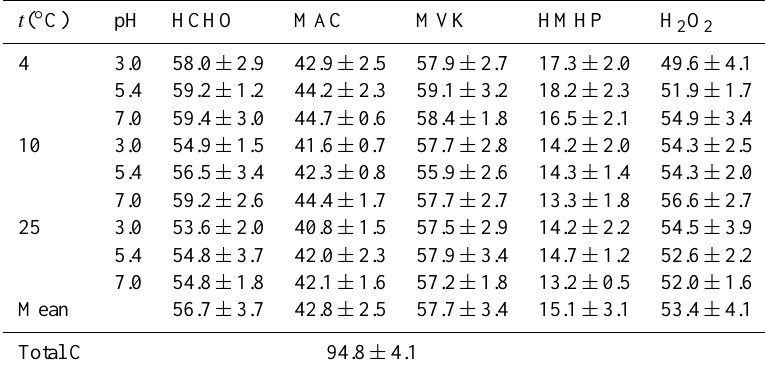
Table 1. Molar yields (% mean ± 2 σ ) of products in the aqueous ozonolysis of isoprene under different conditions. t ( ◦ C)